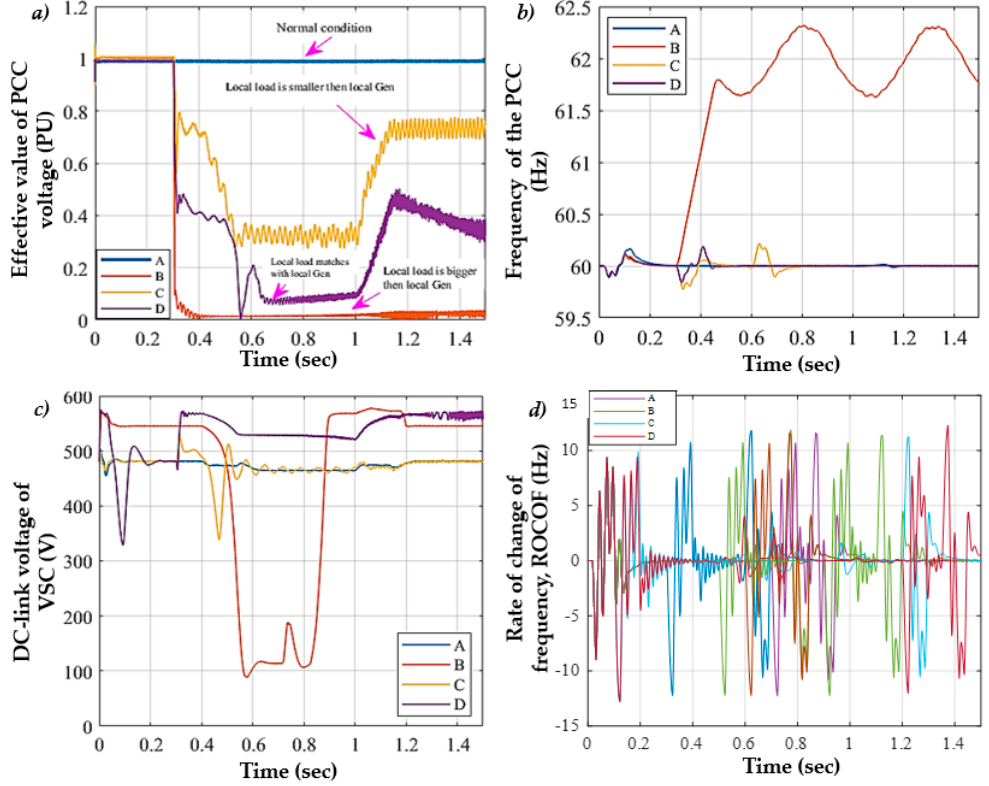
Figure 9. Simulation case of different loads that match with DPG, ( a ) the effective value of the voltage at the point of common coupling; ( b ) frequency value at the point of common coupling; ( c ) direct current-link voltage of voltage source control; and ( d ) rate of change of frequency.